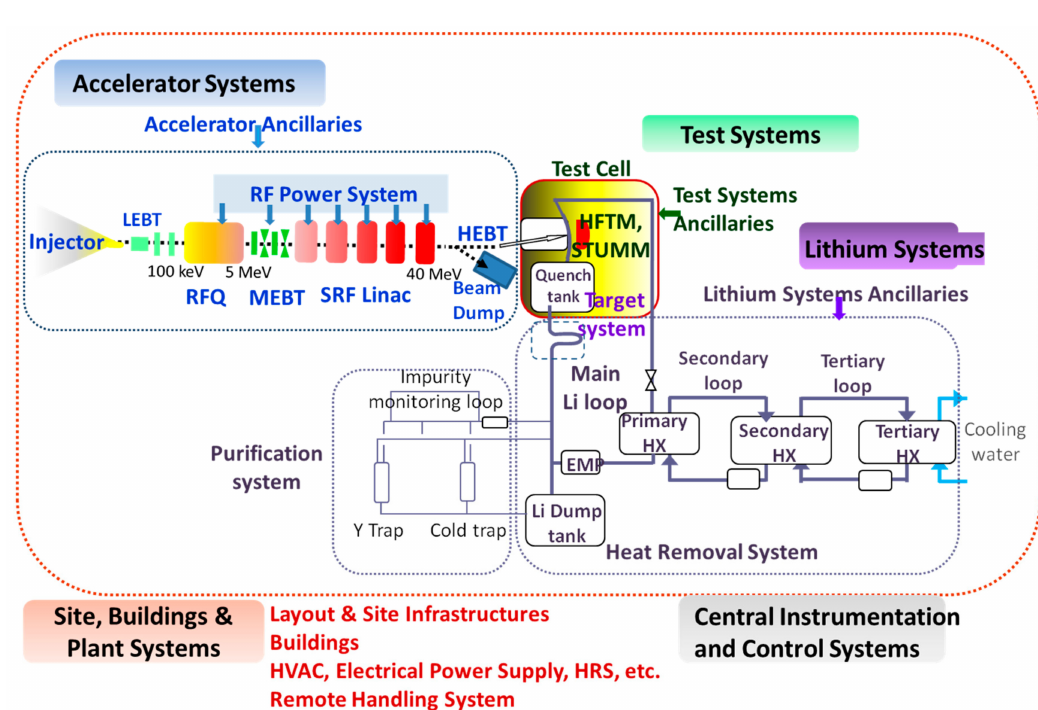
Figure 1. IFMIF-DONES (International Fusion Material Irradiation Facility-DEMO Oriented NEutron Source) plant systems configuration (LEBT stands for ‘Low Energy Beam Transport’, RFQ for ‘Radiofrequency Quadrupoles’, MEBT for ‘Medium Energy Beam Transport’, SRF for ‘Superconducting Radiofrequency’, HEBT for ‘High Energy Beam Transport’, HFTM for ‘High Flux Test Module’, STUMM for ‘Start-up Monitoring Module’, EMP for ‘Electromagnetic Pump’, HX for ‘Heat Exchanger’, HVAC for ‘Heating, Ventilation and Air Conditioning’, HRS for ‘Heat Removal